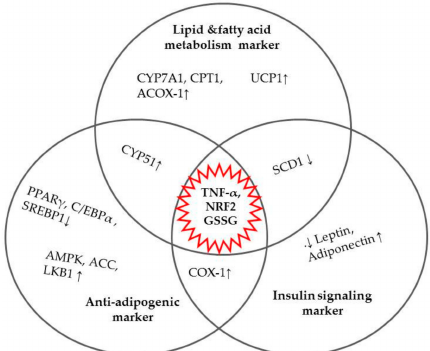
Figure 2. Transcription factors, mRNA expressions, and cytokines involved in the anti-obesity mechanism of the fucoxanthin (FXN), and astaxanthin (ASX) xanthophyll carotenoids. Arrow pointing down ( ↓ ) represents down-regulation, while upward position ( ↑ ) denoted